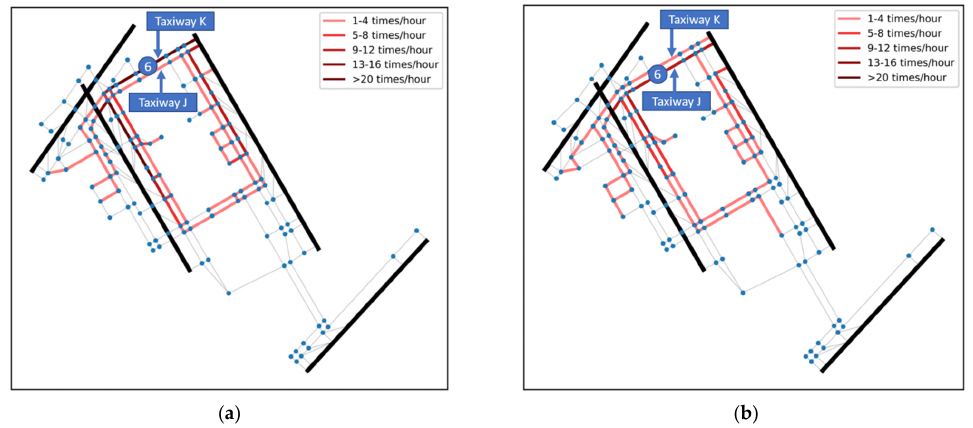
Figure 14. Taxiway usage frequency map of take-off aircraft. ( a ) Observed data. ( b ) Optimized result.